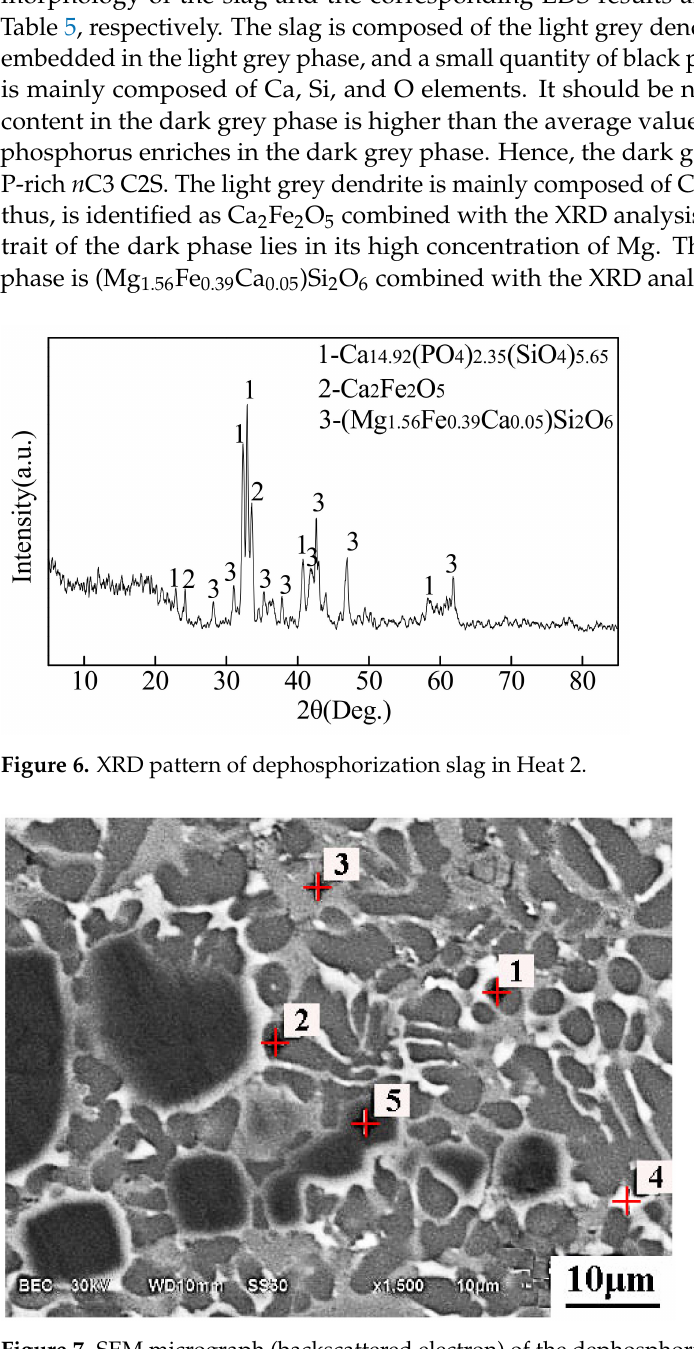
Figure 7. SEM micrograph (backscattered electron) of the dephosphorization slag in Heat